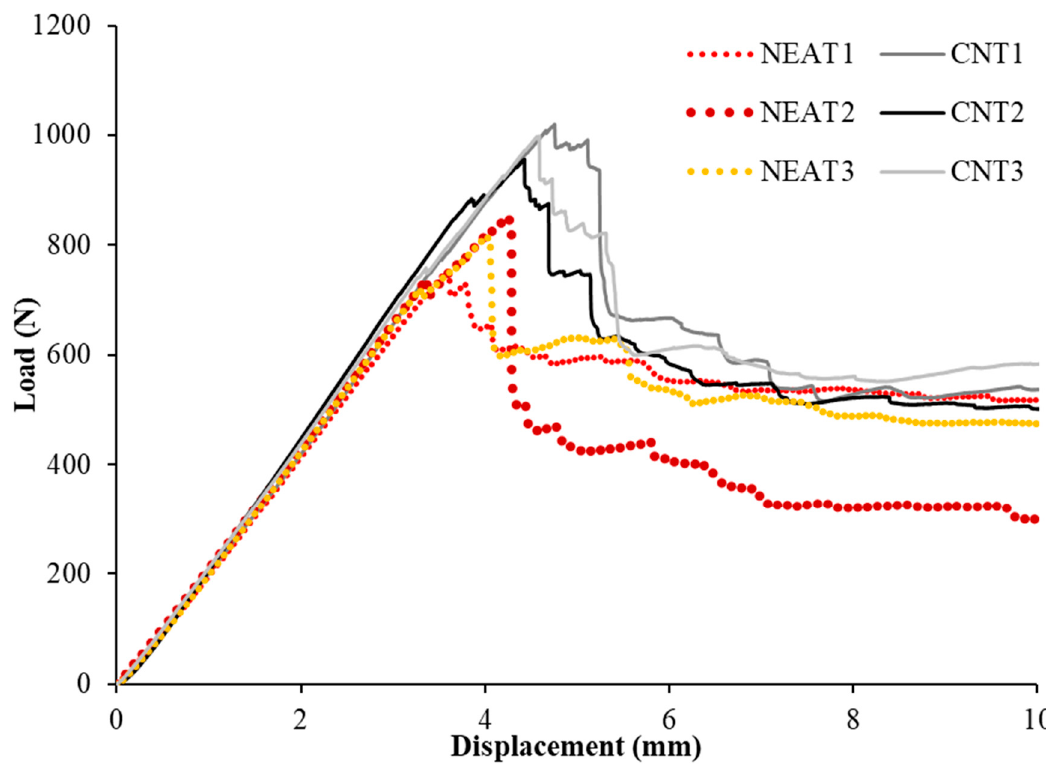
Figure 5. Bending test results.